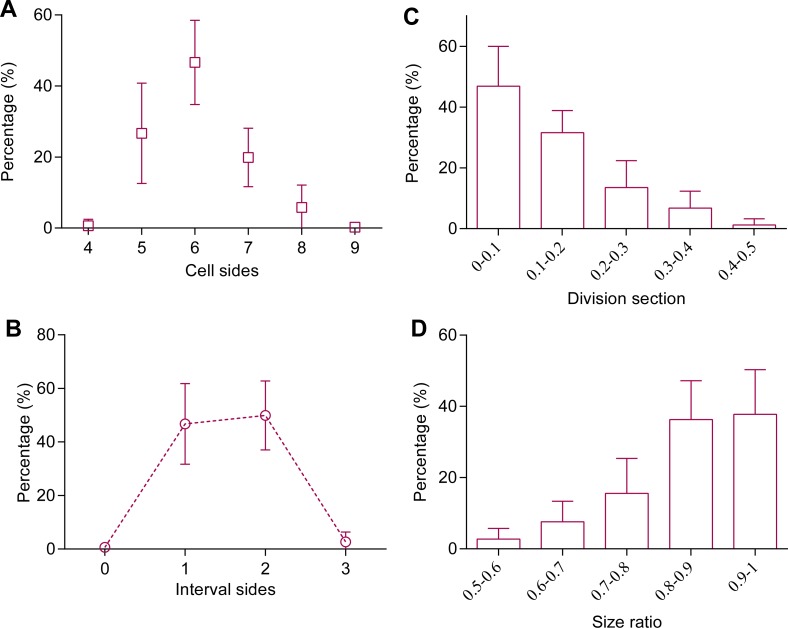
Cell division cut at middle of selected paired-sides.(A) Distribution of cell sides before cell division (187 cells in 8 thalli were examined). (B) Cell division favoring transection of unconnected paired sides (99%). The interval sides between paired sides indicates the relative positions on a polygonal cell before cell division, here the smaller of the two numbers enumerated from opposite directions. (C–D) Distributions of (C) division sections (267 cells in nine thalli were examined) and (D) size ratios of daughter cells (227 cells in nine thalli were examined). Division section indicates the relative distance between midpoint of a side and transection position on that side. The size ratios of daughter cells referred to the ratio of the small daughter cell to the big one. Sample numbers are shown in parentheses. The data are expressed as mean ± SD.